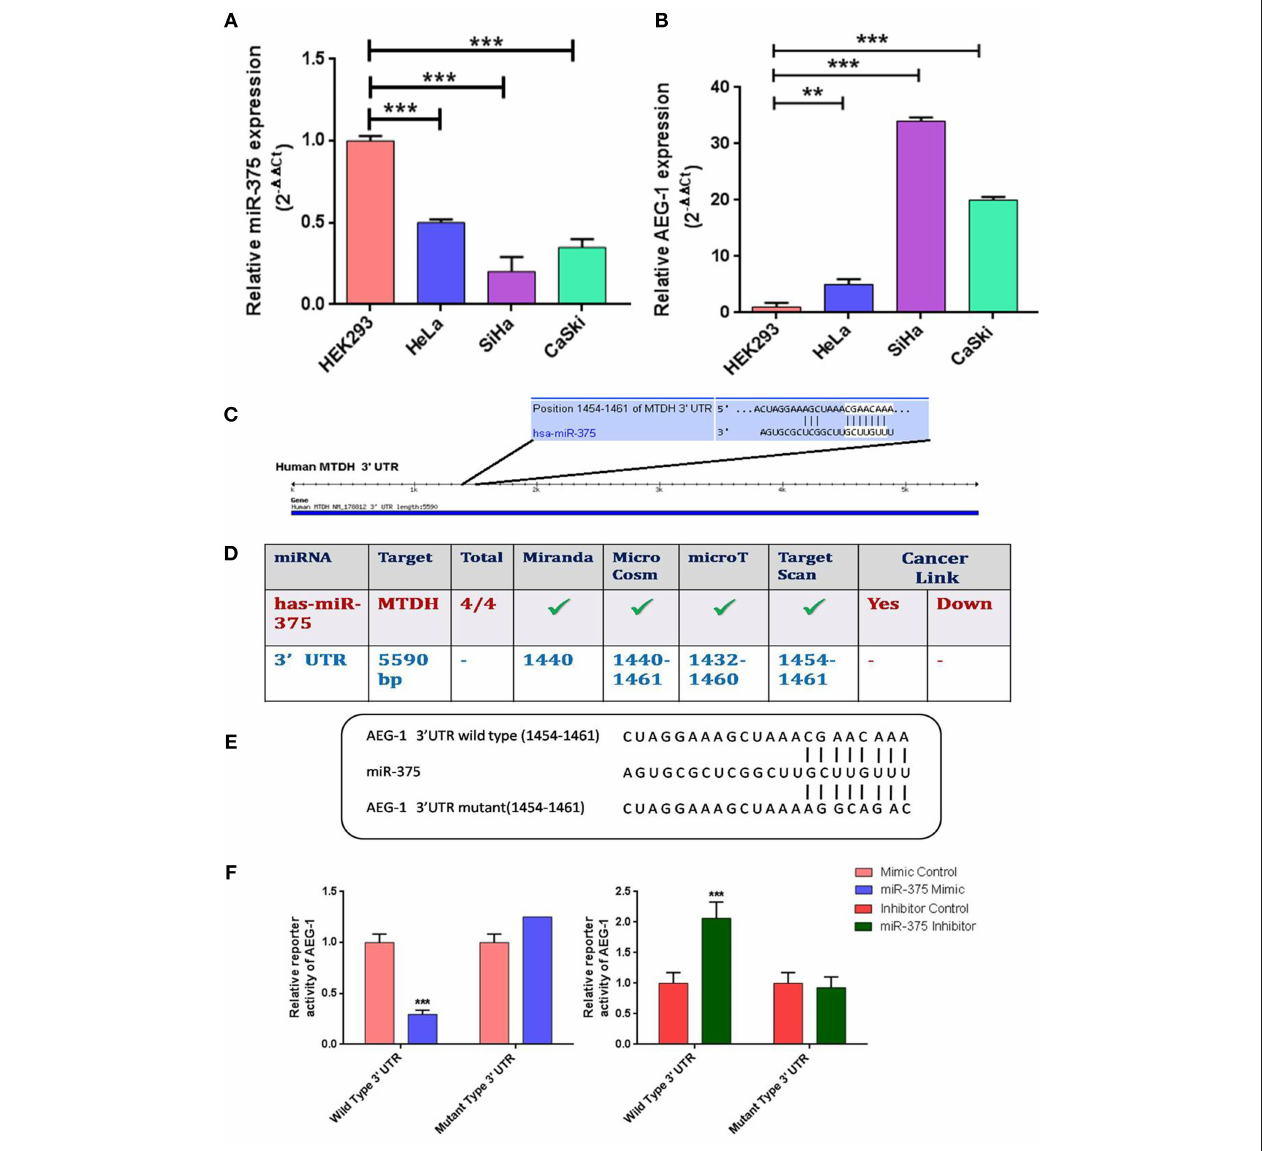
FIGURE 1 | Relative expression levels of miR-375 and AEG-1 in normal and cervical cancer cell lines. Quantitative Real-Time PCR was performed to analyze the expression level of miR-375 (A) and AEG-1 (B) from normal and cervical cancer cells, RNU6 and GAPDH were used to normalize the expression. The putative AEG-1 3’UTR binding sites of miR-375 (C) were confirmed by using different target prediction bioinformatics tools (D) . Wild-type (WT) and mutant (MUT) miR-375-binding sites in AEG-1 3 ′ UTR and miR-375 binding sequence are shown (E) . psiCHECK-2 vector containing AEG-1 3’UTR either with wild-type miR-375-binding site (WT) or mutated site (MUT) was co-transfected with miR-375 mimic, miR-375 Inhibitor and their Negative Controls in HEK293T cells and luciferase assay were performed (F) . Error bars represent mean ± s.d. and P- values are represented as ** P < 0.05, *** P < 0.001 compared to the corresponding